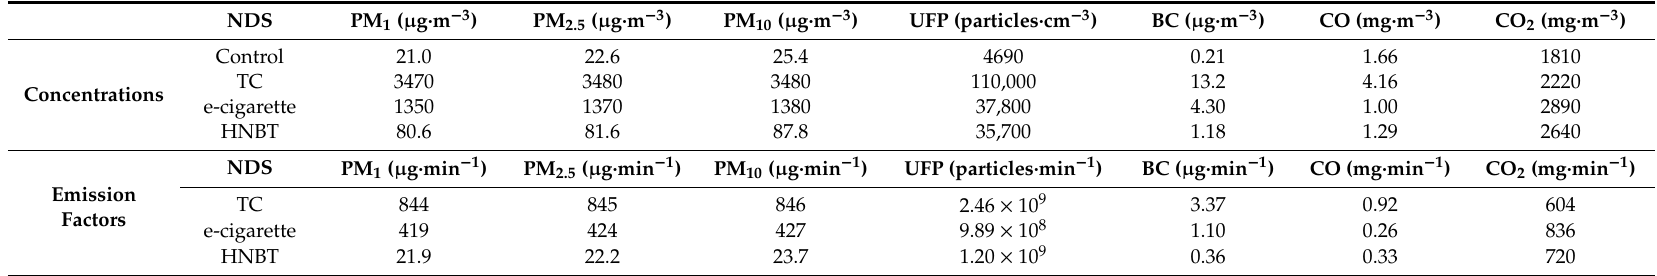
Table 1. Air pollutant average concentrations and emission factors for traditional cigarettes (TC), e-cigarettes and heat-not-burn tobacco (HNBT) in the home. NDS, nicotine delivery systems; UFP, ultrafine particles; BC, black